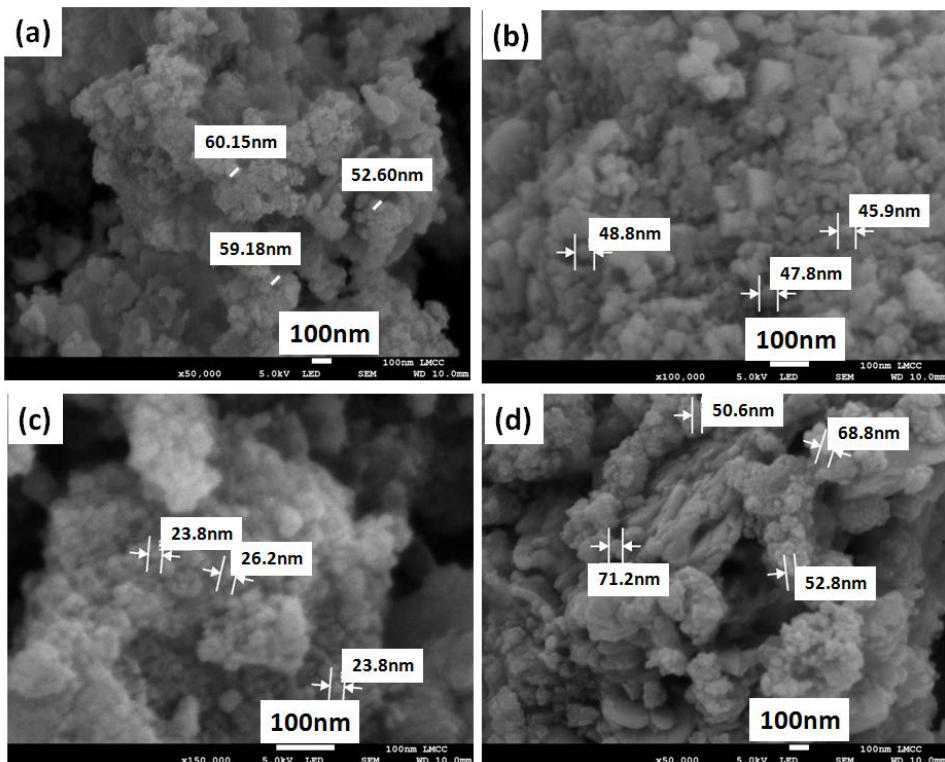
Figure 4. SEM images of ( a ) pure MgS, ( b ) MgS doped with 3% w/w BaO, ( c ) MgS doped with 5% w/w BaO and ( d ) MgS doped with 7% w/w BaO.